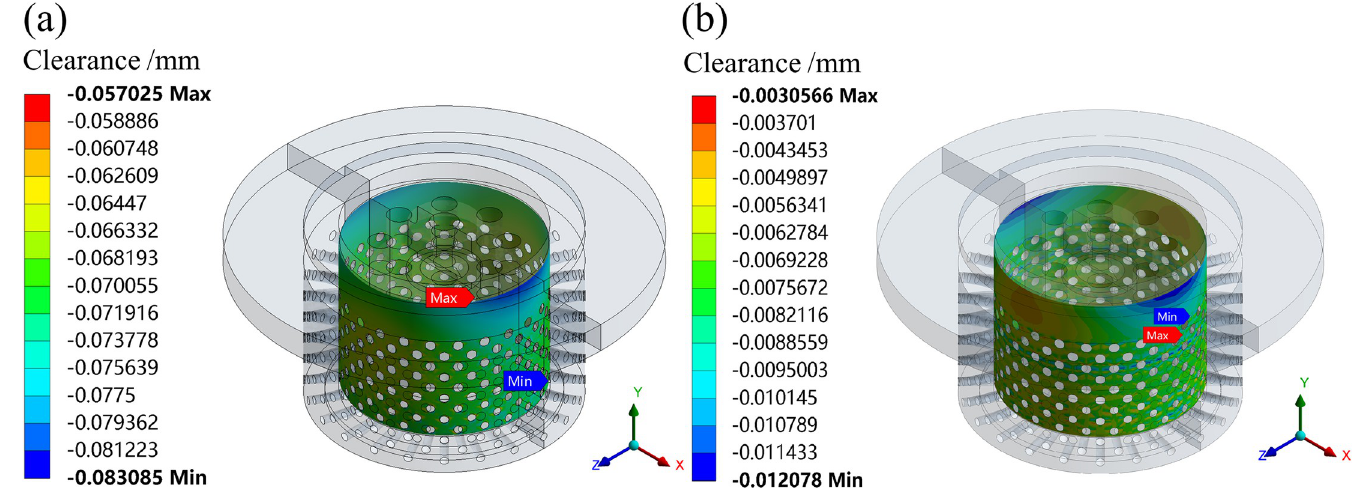
Fig 9. Clearances after deformation of the matching surface at a 10% opening. (a) Initial clearance: 0.073 mm. (b) Initial clearance: 0.010 mm.